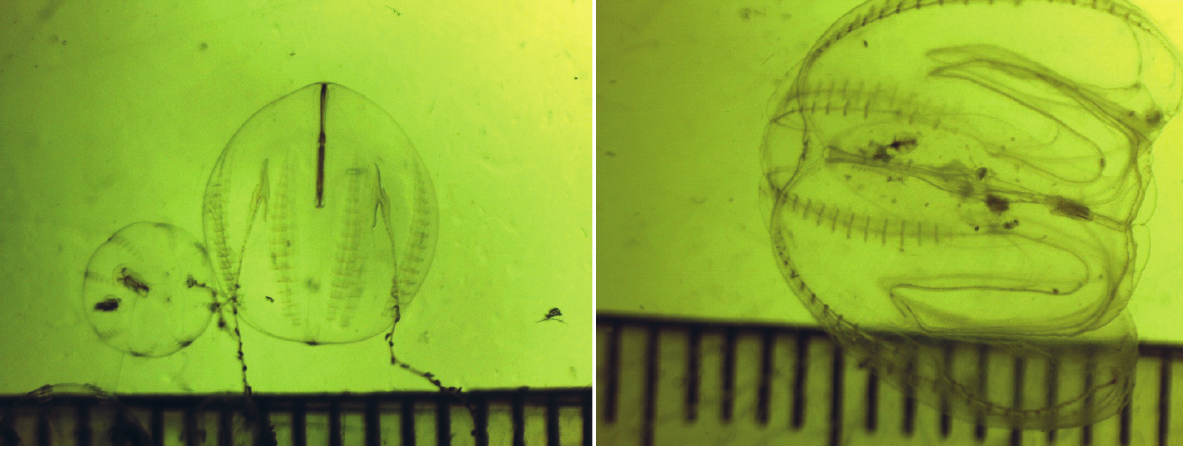
Figure 4. ( left ) Pleurobrachia pileus ; ( right ) Mnemiopsis leydi collected in Løgstør Bredning 2 October 2012. Interval on scale = mm. Photo: Hans Ulrik Riisgård.